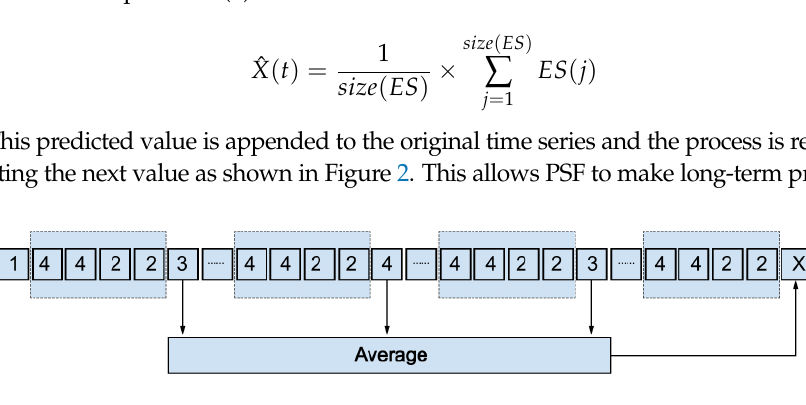
Figure 2. Prediction with PSF algorithm (Source: